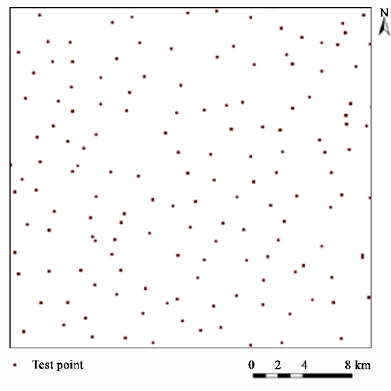
Figure 3. Distribution of test samples.